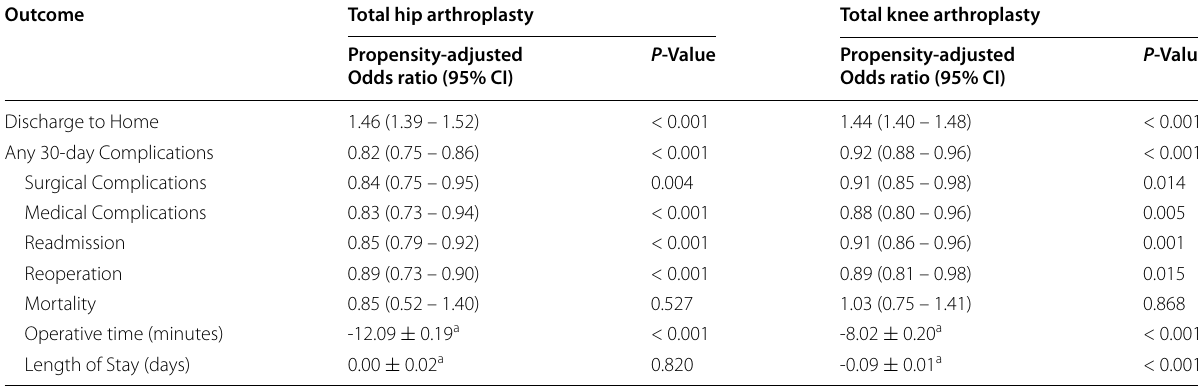
a Operative time and LOS are reported as unstandardized beta coefficients representing change in unit time if spinal anesthesia was used